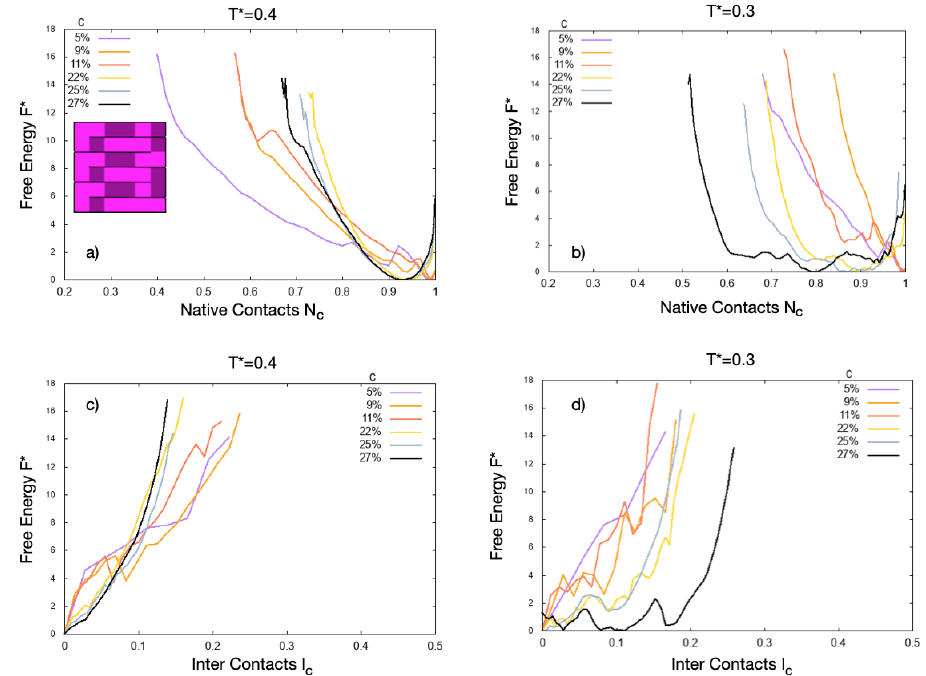
Figure 1. The snake -proteins free energy changes with concentration c and temperature T ∗ . The concentrations go from c = 5% (violet) to 27% (black), as indicated in the legend. ( a ) Inset: Native structure of the snake protein; the dark/light cells are hydrophobic/hydrophilic amino acids. Main panels: F ∗ ( N c ) at warm temperature ( T ∗ = 0.4), and ( b ) at ambient temperature ( T ∗ = 0.3), has a minimum that moves from N c = 1 at low c to N c < 1 at high c , with a change between the folded and the unfolded state at 11% < c < 22%, corresponding to 5 ≤ N p ≤ 10 proteins in our system. The change is greater at ambient conditions. ( c ) For warm temperature and the same concentrations, F ∗ ( I c ) has a minimum always at I c = 0, showing that the proteins do not aggregate at this temperature, regardless if they are folded or unfolded. ( d ) The result is different at ambient conditions. The free energy develops several minima at the larger concentration, c = 27% (12 proteins), showing that the unfolded proteins aggregate at high concentration. In all the panels, the curves at lower concentrations are noisier than those at higher c because the corresponding averages are over smaller numbers of proteins. Hence, the fluctuations along the curves are an indication of the error bar on the estimates. In general, a detailed study of the free-energy landscape to estimate the possible occurrence of free-energy barriers would imply much larger statistics, which is out of the scope of the present